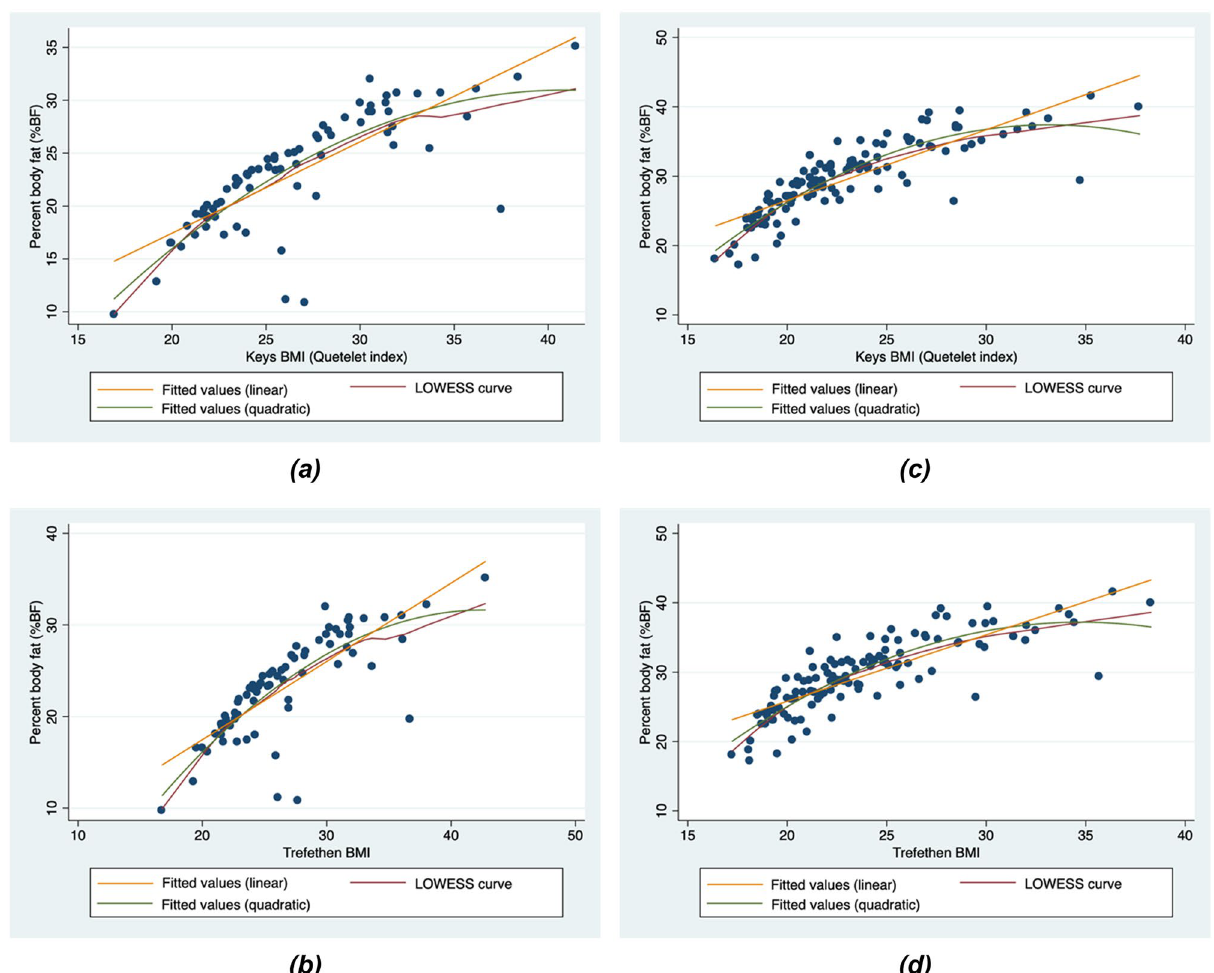
Figure 1. Scatterplots of BMI and %BF values per BMI measure type among males (a,b) and females (c,d) with LOWESS (locally weighted scatterplot smoothing) curves and fitted straight lines and fitted quadratic curves. BMI body mass index, %BF body fat